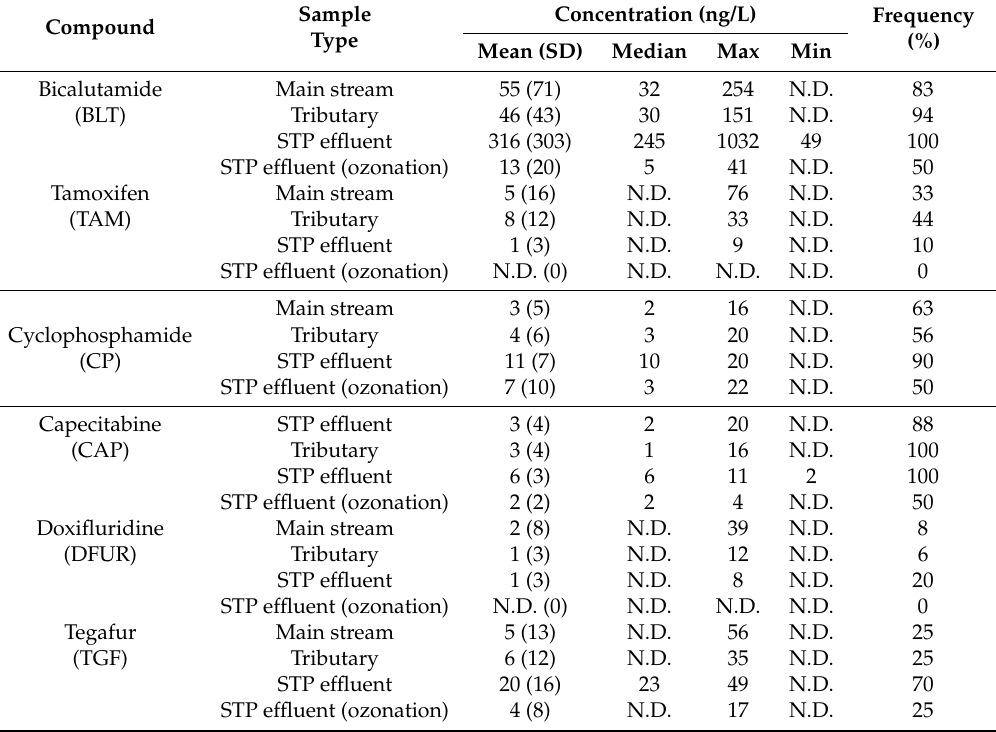
Table 5. Detection of the target anticancer drugs in river waters and STP effluents (n = 24 (main stream), n = 16 (tributary), n = 10 (STP effluent), n = 10 (STP effluent—ozonation)) (reproduced from